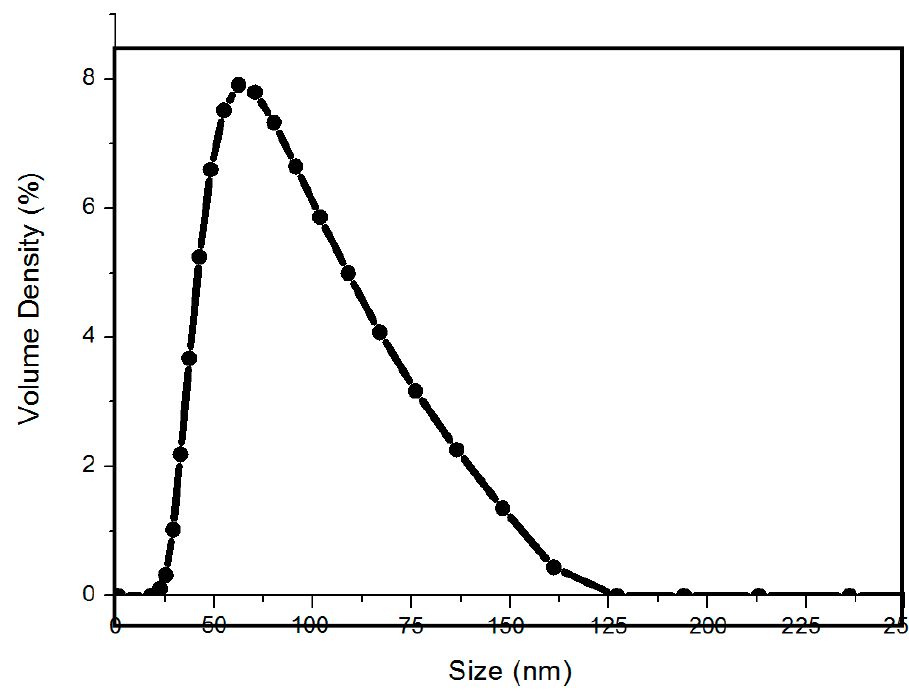
Figure 3. Particle size distribution of silver nanoparticles.